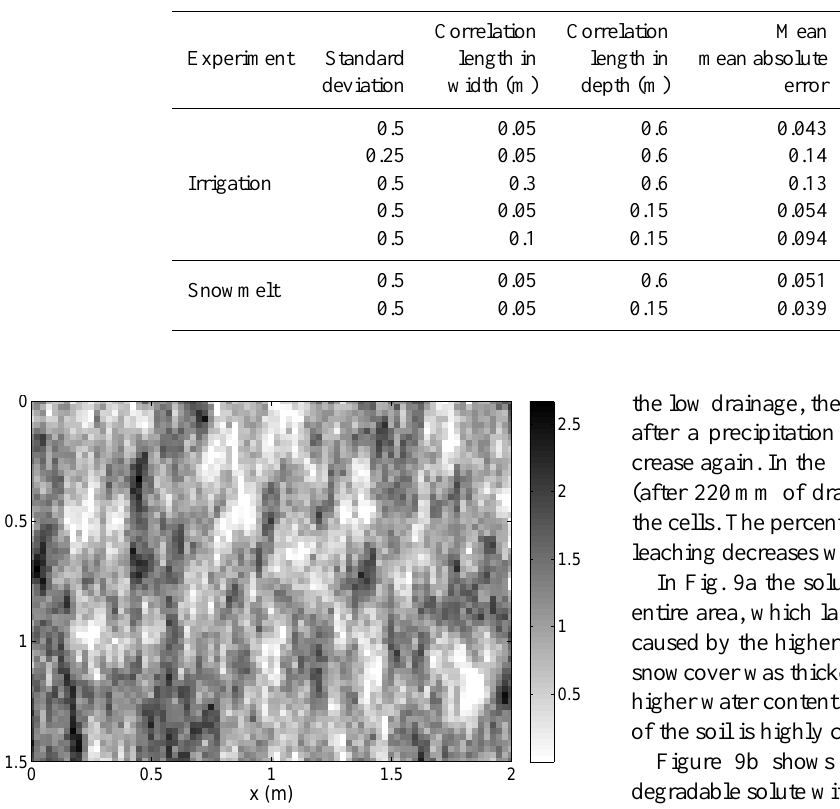
Fig. 8. Scaling factor of the saturated hydraulic conductivity (-) in Fig.8. Scalingfactorofthesaturatedhydraulicconductivity(-)indepth z andwidth x ,withastandarddeviation depth z and width x , with a standard deviation of 0.5m and corre- of 0.5 m and correlation lengths λ z =0.15 m and λ x =0.05 m. lation lengths λ z = 0 . 15m and λ x = 0 .